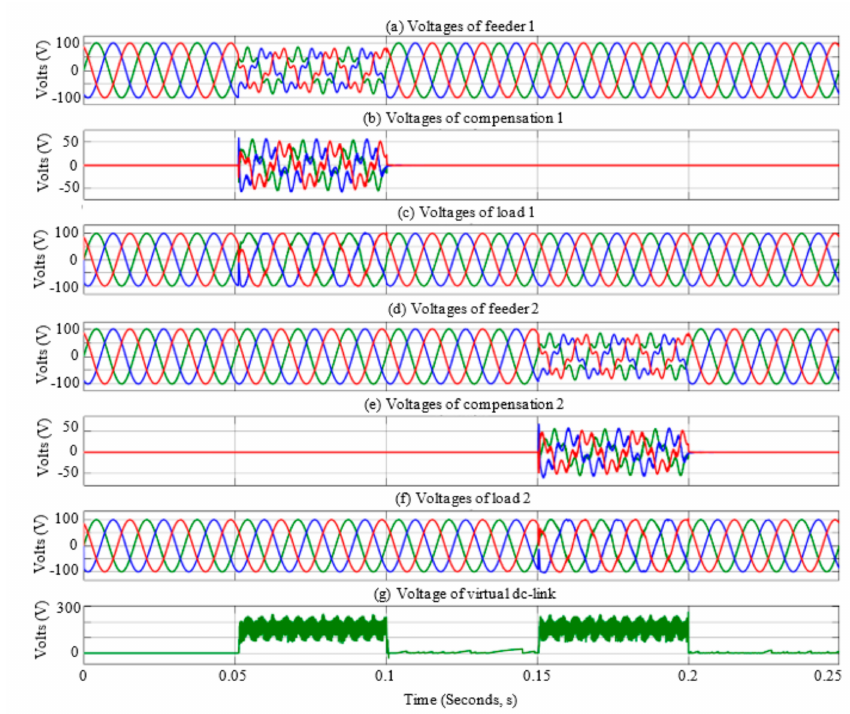
Figure 11. System waveforms in the compensation of voltage sags and harmonic distortion. ( a – c ) feeder 1 waveforms; ( d – f ) feeder 2 waveforms; ( g ) virtual dc-link voltage